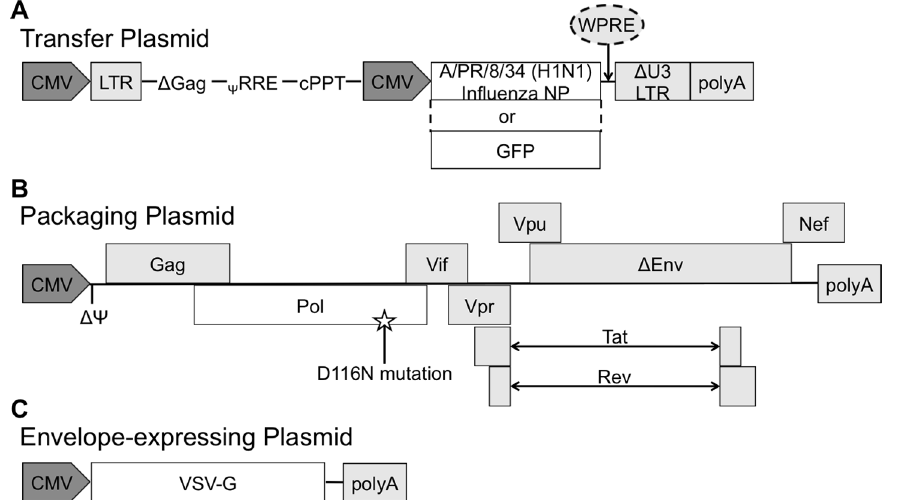
Figure 1. Schematic of lentiviral vectors. ( A ) Lentiviral transfer plasmid that expresses either NP (pTY2-CMV-NP), GFP (pTY2-CMV-GFP) or no exogenous protein (pTY2-CMV-empty). The arrow indicates where a woodchuck hepatitis virus posttranscriptional regulatory element (WPRE) is added for the production of the pTY2-CMV-NP WPRE and pTY2-CMV-GFP WPRE constructs. ( B ) Lentiviral packaging plasmid, pCHelp/IN- and pCMV D R8.2, which are differentiated by the presence of the mutation D116N that inactivates the function of the integrase protein in pCHelp/IN- (indicated by a star). ( C ) Envelope-expressing plasmid, pMD.G, which produces the vesicular stomatitis G protein (VSV-G). Abbreviations: cytomegalovirus promoter (CMV), long terminal repeat (LTR), deleted gag gene ( D Gag), packaging signal ( Y ), rev responsive element (RRE), central polypurine tract (cPPT), nucleoprotein (NP), green fluorescent protein (GFP), deleted unique 3 9 region ( D U3), bovine growth hormone polyadenylation signal (polyA), deleted packaging signal ( DY ), nonfunctional envelope ( D